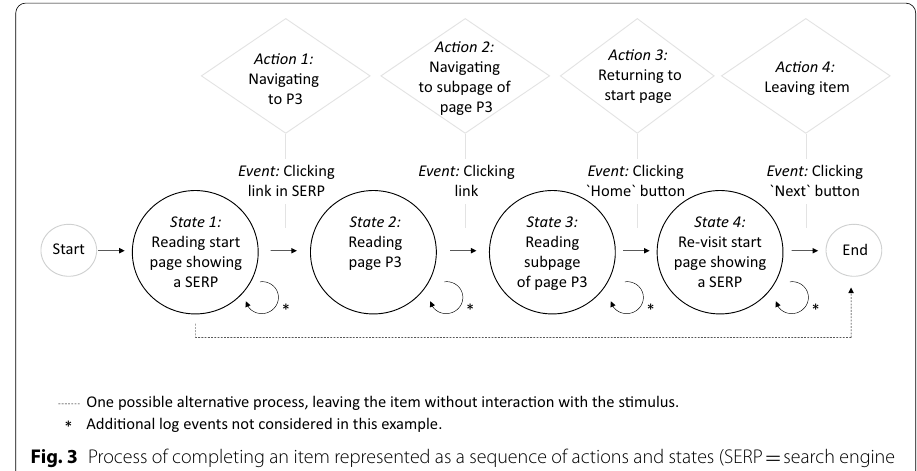
Fig. 3 Process of completing an item represented as a sequence of actions and states (SERP results